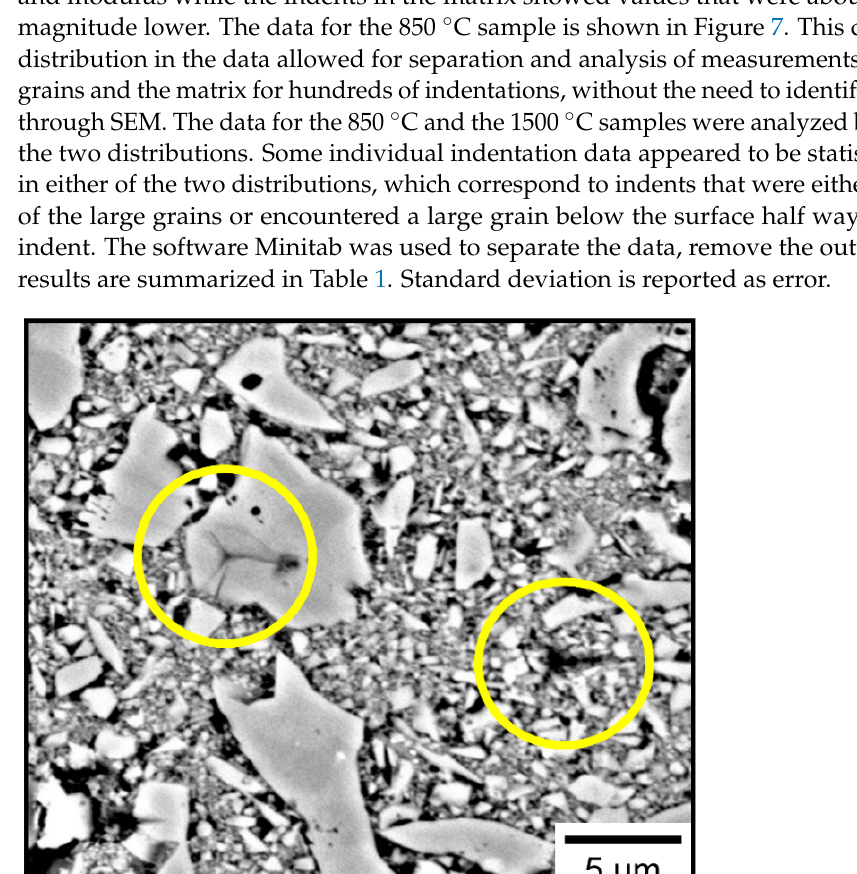
Figure 6. SEM image of the indentations, showing an indent in the large grains, and an indent in the matrix.